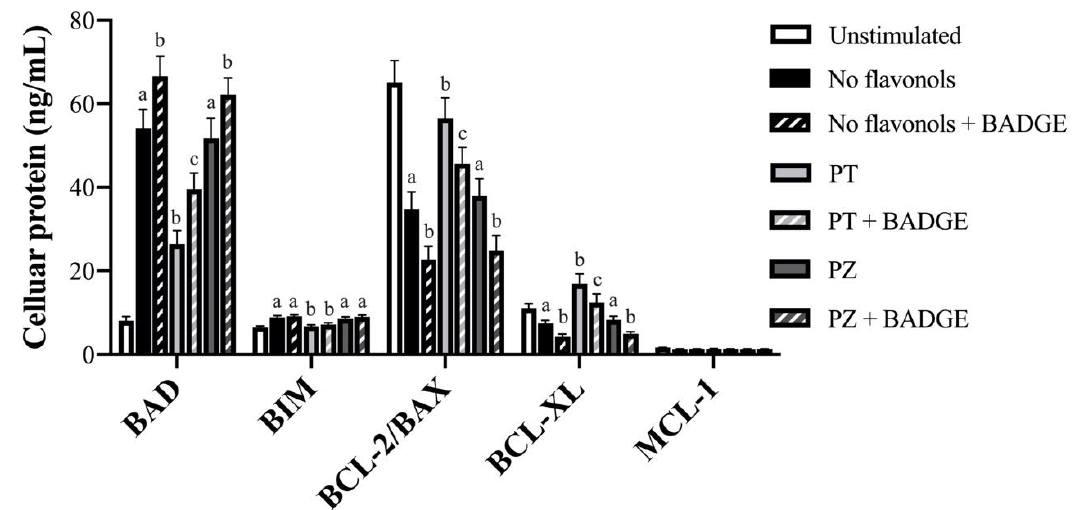
Figure 6. Cellular protein levels of regulators of apoptosis of the B-cell lymphoma 2 (BCL-2) protein family (BCL-2-associated agonist of cell death (BAD), BCL-2-like protein 11 (BIM), BCL-2/BCL-2-like protein 4 (BAX), B-cell lymphoma-extra-large (BCL-XL)) in LPS + CoCl 2 -stimulated adipocytes co-treated with PT or PZ, with or without BADGE. Values are means ± SEM; n = 9/treatment. Data were analyzed using a two-way ANOVA and means without a common letter differ within cultures treated ± BADGE, p < 0.05.